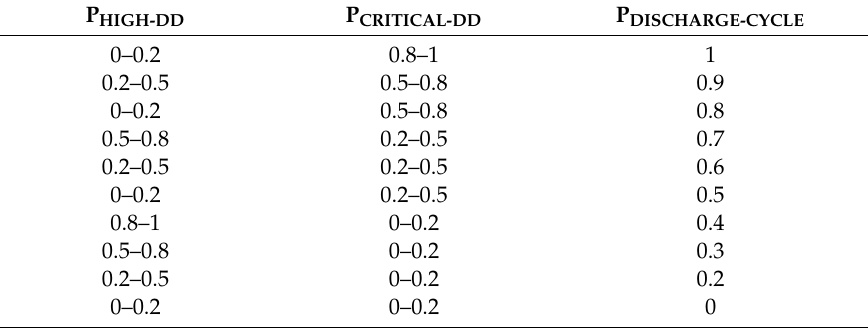
Table 10. Probabilities for occurrence of a discharge